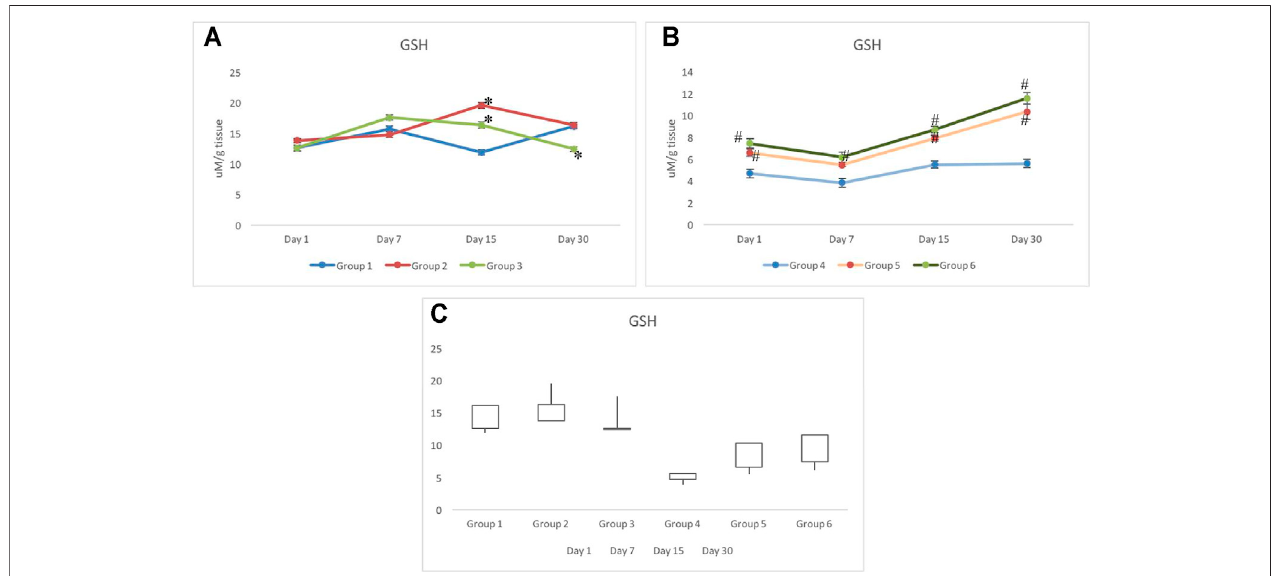
FIGURE 2 | Response of reduced glutathione in non-irradiated (A) and irradiated (B) groups pretreated with CRE/CRE-AgNPs/sham. Gain/loss in the activity of glutathione has been noted and presented through the box plot (C) . * p < 0.05 signi fi cance level was measured against group 1. # p < 0.05 signi fi cance level was measured against group